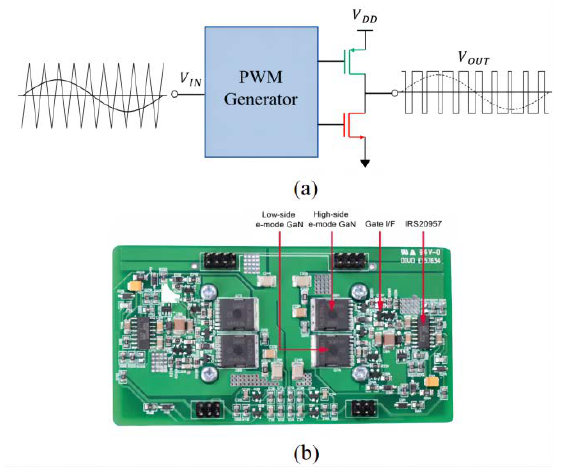
Figure 3. The topology and wave ( a ) form for Class D amplifier and GaN-based design ( b ) [14].